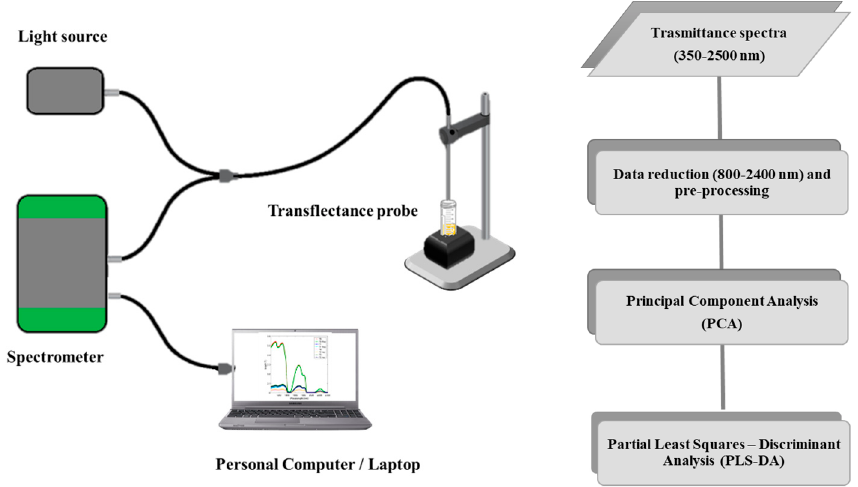
Figure 1. Schematic representations of the utilized spectrophotometer ( left ) and the experimental set-up ( right